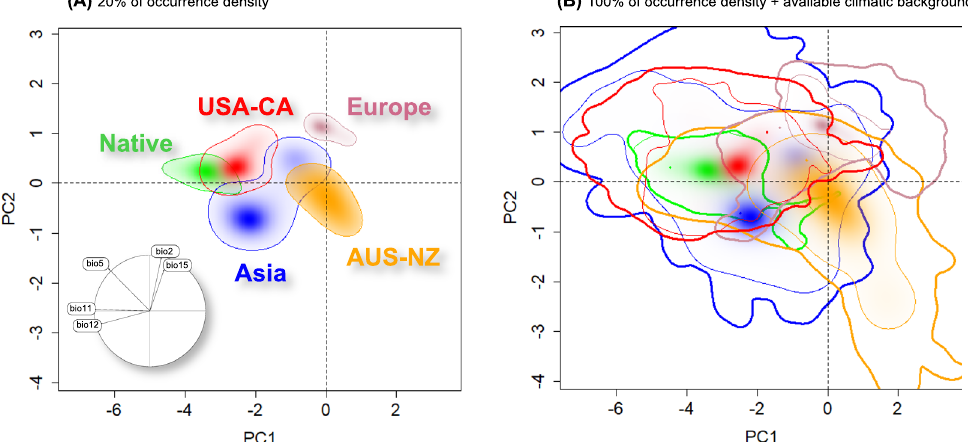
Figure 5. Global climatic space constructed over all background areas and realized niches of Lilium lancifolium , showing overlaps between native (Korea), archaeophyte (ASIA) and neophyte (USA-CA, AUS-NZ, EUR) distribution ranges, plotting a solid line representing the 20% of occurrence density ( A ), and 100% of occurrence density with a thin line and 100% of available climatic background with a thick line. ( B ) The left graph includes the contribution and direction of each variable to the two-first components of the PCA-env.